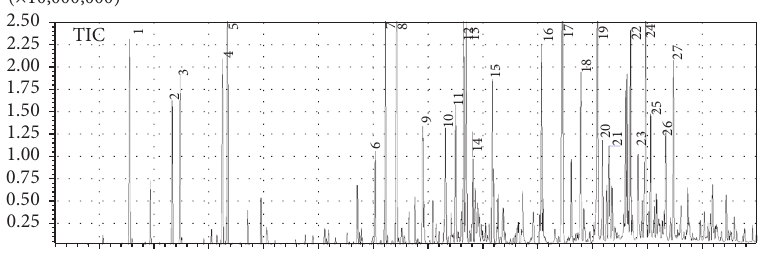
Figure 1: GC/MS chromatogram of the EO from T. cilicium. The peaks in the chromatogram belong to the main compounds which are more than 1% of the EO chemical composition: (1) 𝛼 -pinene, (2) 𝛽 -pinene, (3) sabinene, (4) limonene, (5) eucalyptol, (6) 𝛼 -copaene, (7) camphor, (8) linalool, (9) 4-terpineol, (10) alloaromadendrene, (11) trans-verbenol, (12) 𝛼 -terpineol, (13) borneol, (14) germacrene D, (15) Δ -cadinene, (16) spathulanol, (17) sesquisabinene hydrate, (18) (-)-caryophyllene oxide, (19) nerolidol, (20) cis-caryophyllene, (21) 𝛼 -cedrene, (22) 8-hydroxylinalool, (23) spathulenol, (24) 𝛼 -muurolol, (25) 𝛼 -cadinol, (26) epiglobulol, and (27) juniper camphor (the peak numbering given here is not in accordance with peak numbers in Table